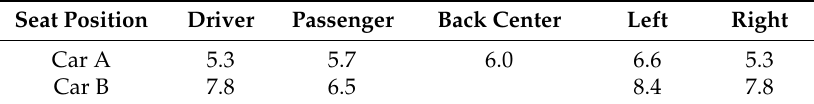
Table 2. Measured initial time delay gap ( ITDG ) [ms] for Experiment 1.